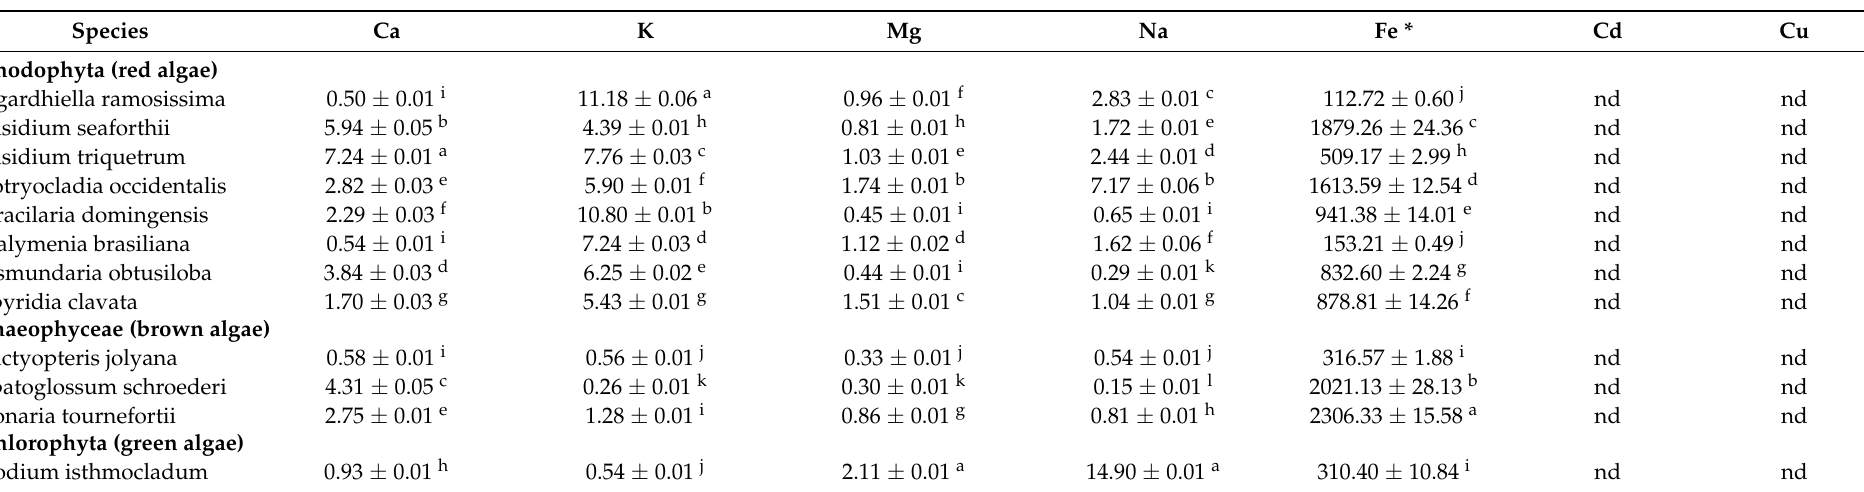
Table 2. Macro (N, P, Ca, K, Mg, and Na) and micro (Fe) elements as well as trace metals of beach-cast macroalgae (g/100 g = % and * ppm on dry mass basis). Values represent the average of three replicates (mean ± SD), and letters indicate statistical significance ( p < 0.05). nd = not